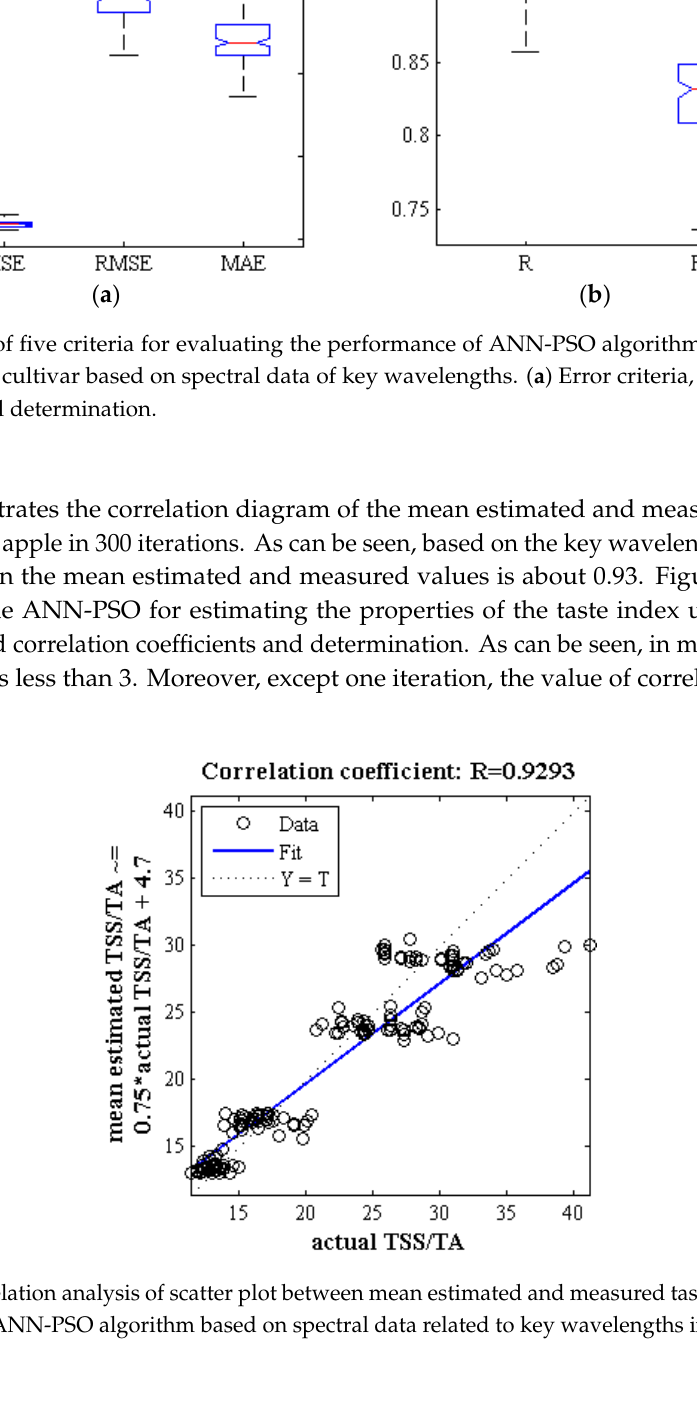
Figure 2. Correlation analysis of a scatter plot between the mean estimated and measured chemical properties of TA of Gala cultivar (test set) by ANN-PSO algorithm based on spectral data related to key wavelengths in 300 replications.